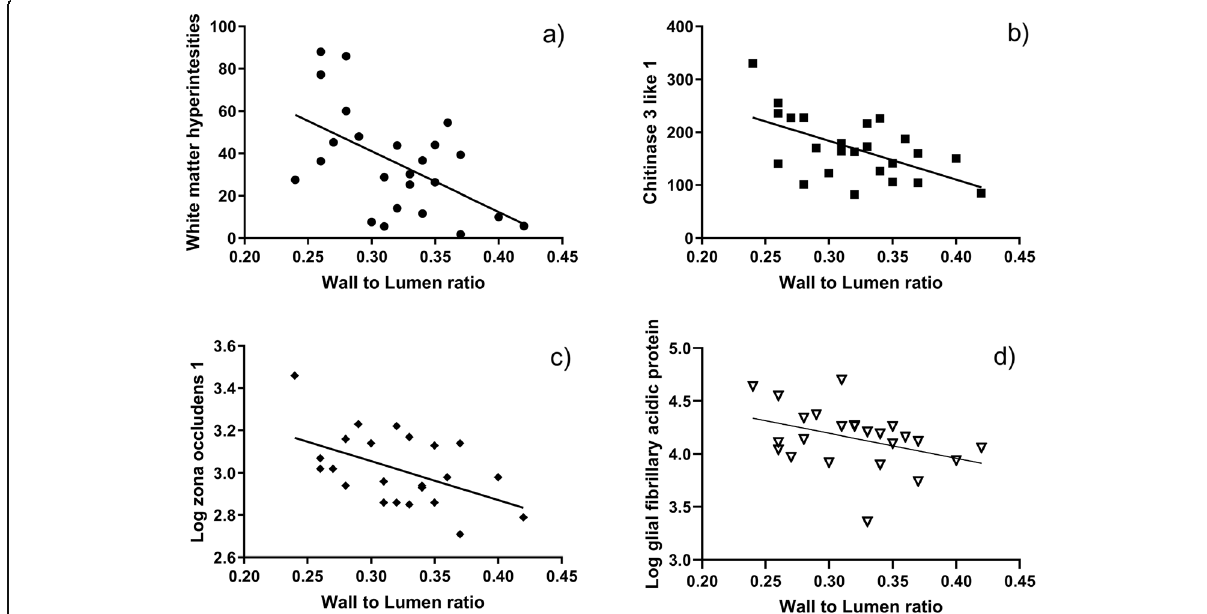
Fig. 4 Correlations between wall to lumen ratio and white matter hyperintensities ( a ), CSF concentration of chitinase 3 like 1 ( b ), zona occludens ( c ), and glial fibrillary acidic protein ( d ) in CSVD patients